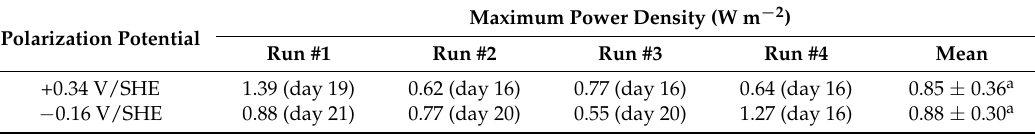
Table 2. Maximum power density recorded at +0.34 V/SHE and − 0.16 V/SHE polarization potentials. Polarization Potential